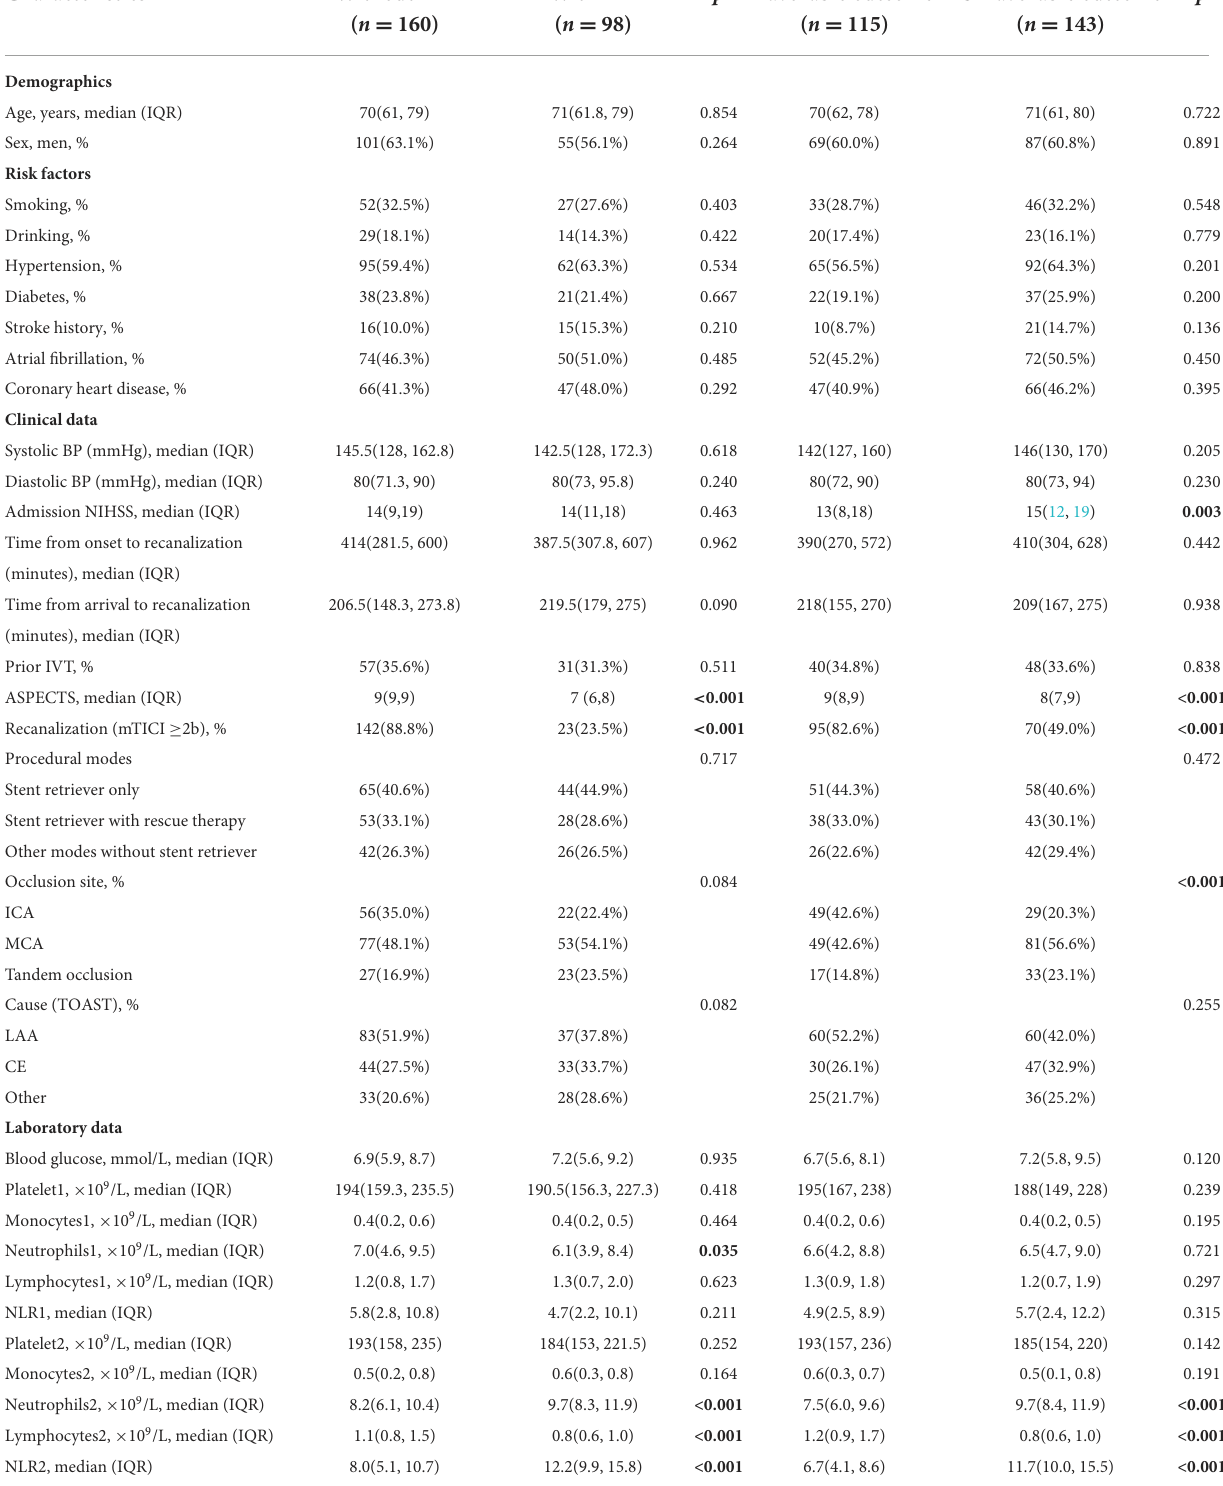
TABLE 1 Baseline characteristics of patients according to the presence/absence of HT and neurological outcomes at 3 months. Characteristics